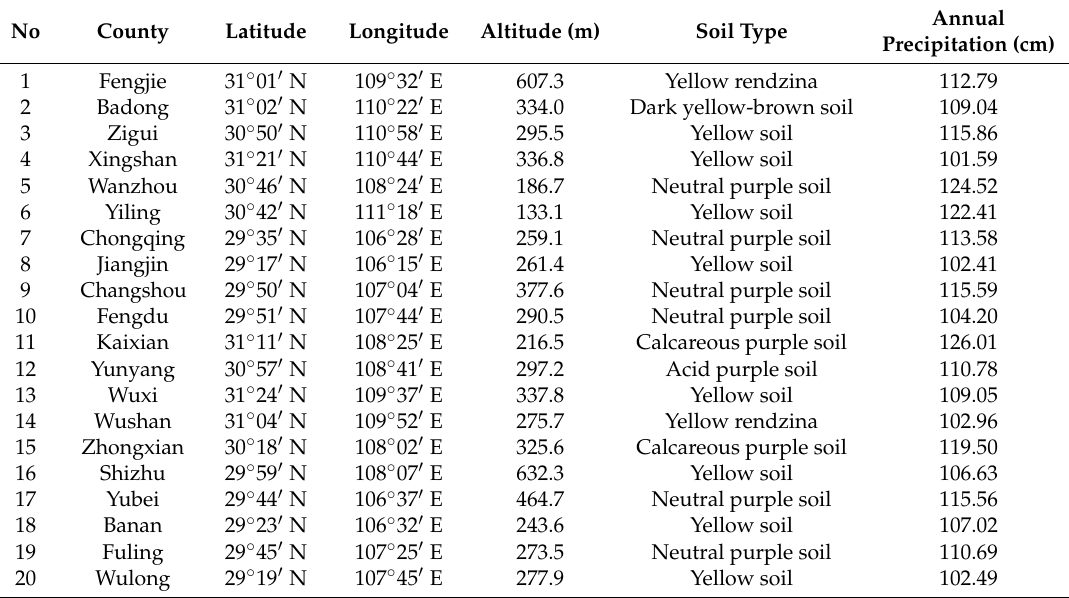
Table 1. The environmental information of the counties in the TGRA.